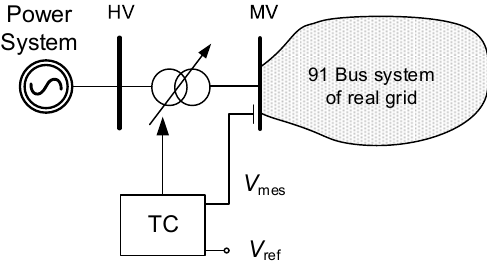
Figure 9. Simplified diagram of the network used in simulation studies.